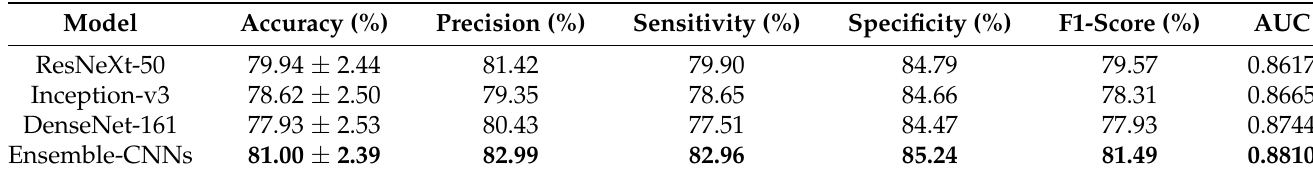
Table 11. The experimental results of the testing data of our proposed five-class COVID-19 database.